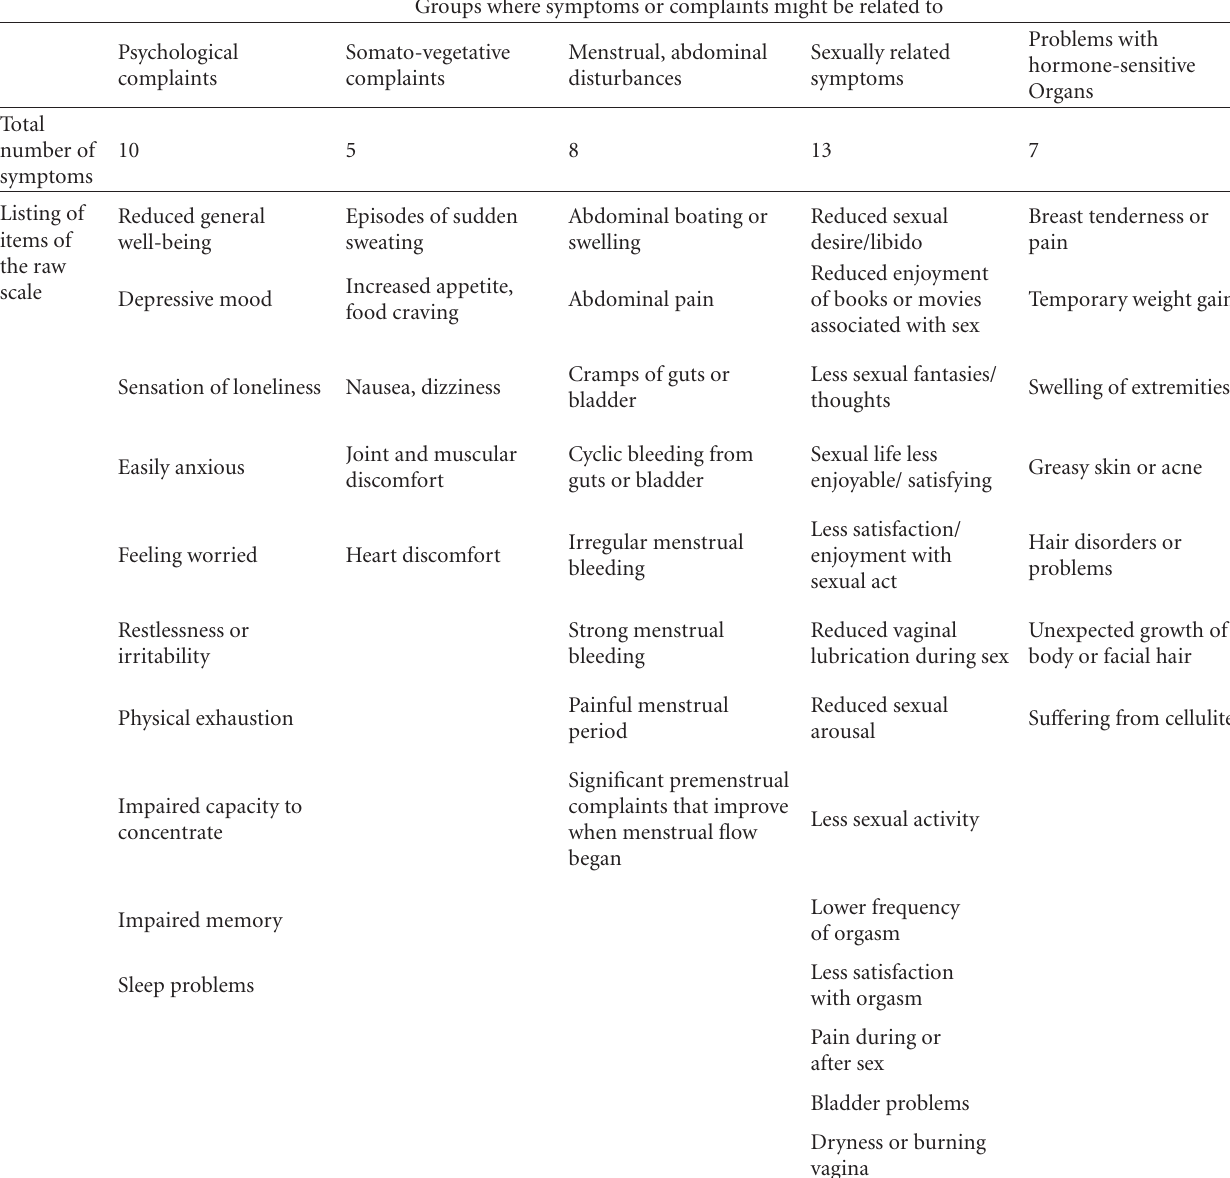
Table 1: Conceptual framework and grouping of the complaints or symptoms possibly relevant for measuring short-term e ff ects of hormones (raw scale). These “multicausal symptoms” were arbitrarily allocated to one of the five groups, that is, the groups are not mutually